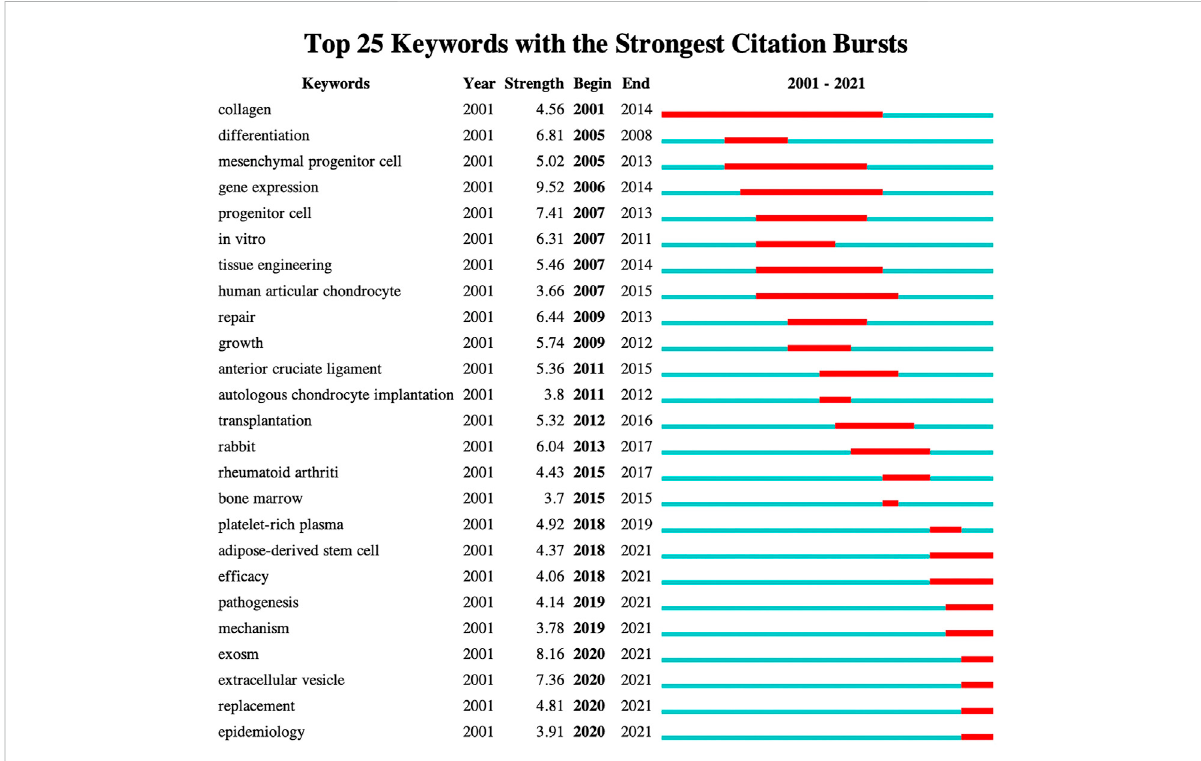
FIGURE 8 Top 25 keywords with the strongest burst value on stem cell therapy for KOA research. The dark blue bar shows years in which keywords received slight increases in co-occurrence, and the red bar indicates that co-occurrence rose sharply.